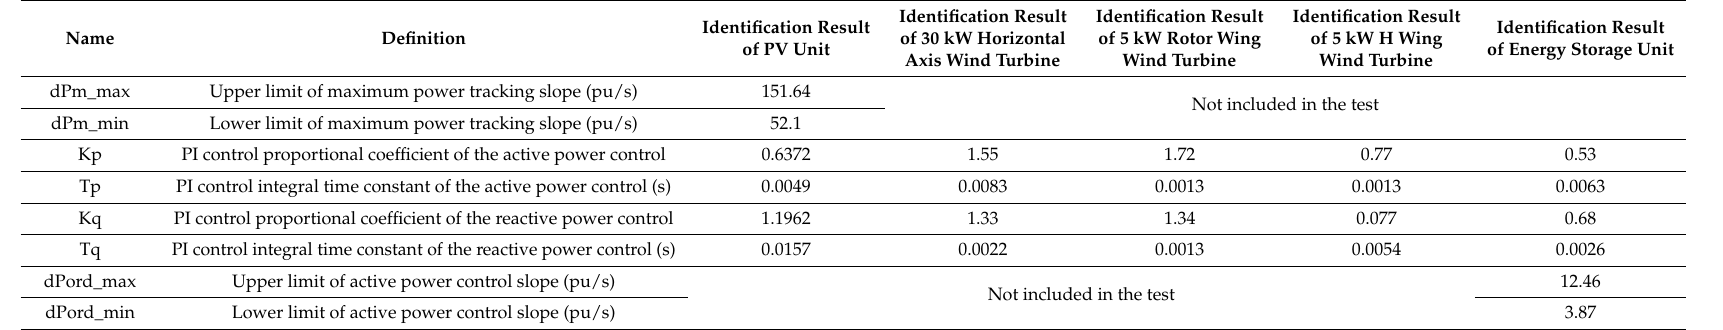
Table 2. Parameter identification results of the wind/PV/energy storage unit in the